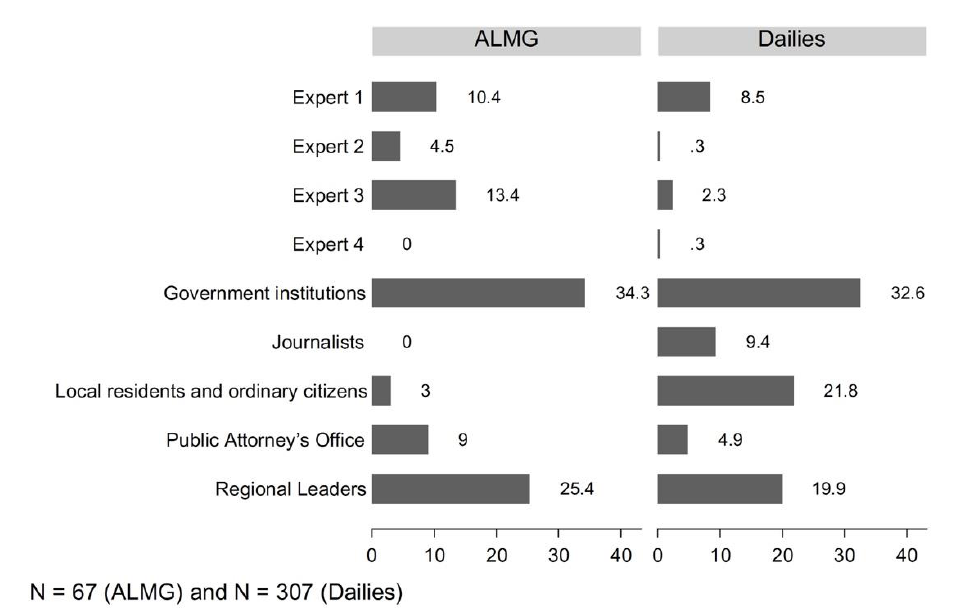
Figure 1: Actors involved in the debate in each type of setting (% values)